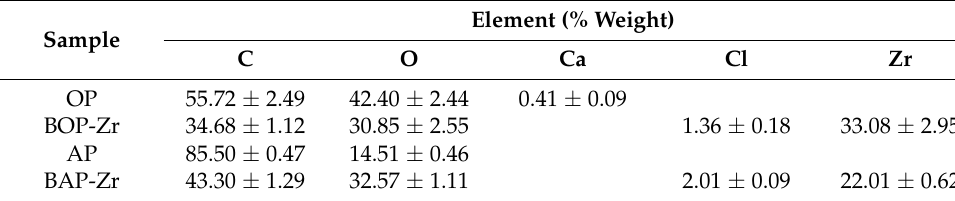
Table 1. Average composition (% weight) of the materials under